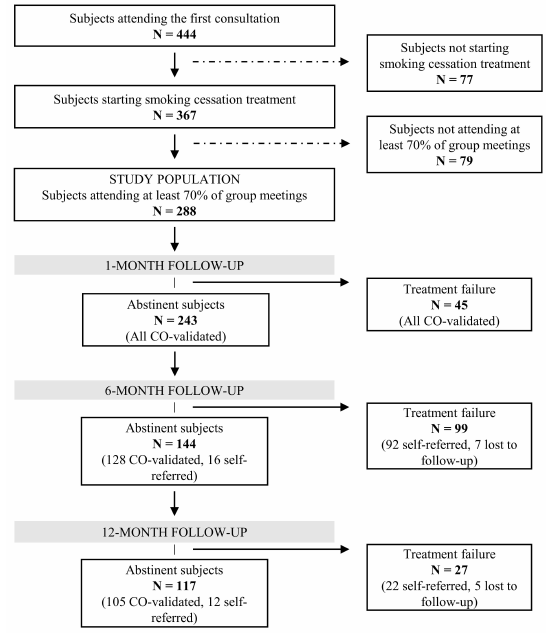
Figure 2. Flow chart of the study